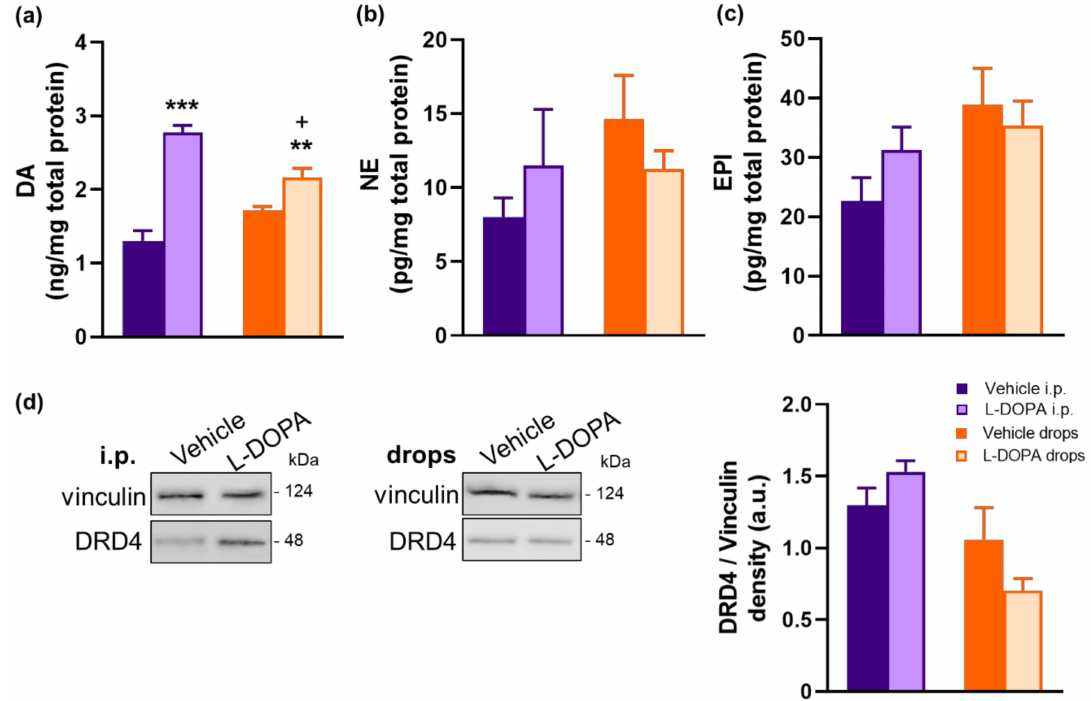
Figure 9. L-DOPA treatment increases retinal DA levels in Gnat1 rd17 mice. ( a ) DA, ( b ) NE, and ( c ) EPI levels in the neuroretina measured by ELISA in EAU Gnat1 rd17 mice treated with vehicle (light purple and light orange bars) or L-DOPA (dark purple and dark orange bars) given i.p. (purple bars) or topically (orange bars) in the form of eye drops. The data are shown as the mean ± SEM of 8 neuroretinas from 4–6 animals per group. Significant differences between groups: *** p < 0.001 by unpaired t -test for comparisons of vehicle and L-DOPA i.p. groups, ** p < 0.01 by paired t -test for comparisons of vehicle-treated contralateral eyes and L-DOPA-treated ipsilateral eyes in the same animals, and + p < 0.05 by unpaired t -test for comparisons of L-DOPA i.p. vs. L-DOPA drops. ( d ) Left: representative Western blots for DRD4 expression in neuroretinas of EAU Gnat1 rd17 mice treated with vehicle or L-DOPA given i.p. or in the form of eye drops. Right: densitometric analysis of relative protein expressions of DRD4. Vinculin was used as a protein-loading control. Results are presented as the mean ± SEM. No significant differences were found after treatment with